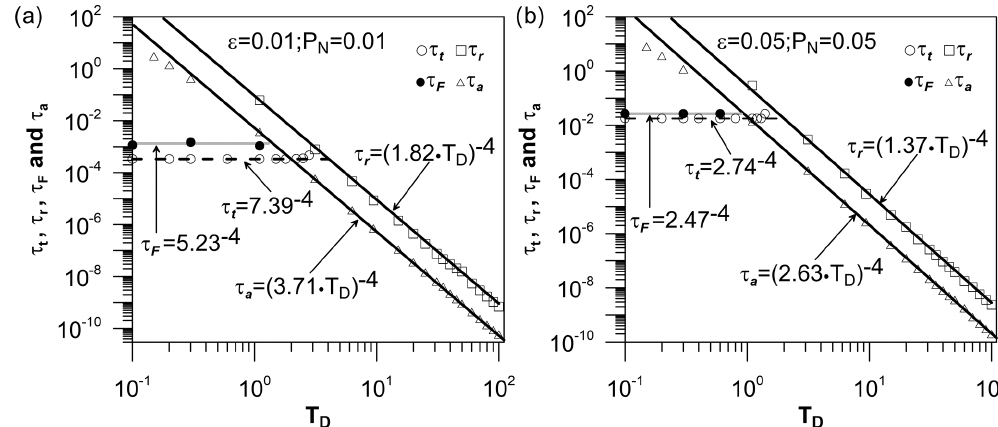
Figure 8. Model results displaying τ t , τ r , τ F , and τ a vs. T D on a log–log scale. τ t , τ r , τ F , and τ a denote the transition time, the reflection time, the fracture time, and the arrival time, respectively. The fit curves for reflection time and arrival time are represented by black lines, for transition time by dashed lines, and for fracture time by grey lines. (a) Numerical simulations with ε and P N = 0 . 01; and (b) numerical simulations with ε and P N = 0 . 05 (see Eqs. 20, 21, and 22).